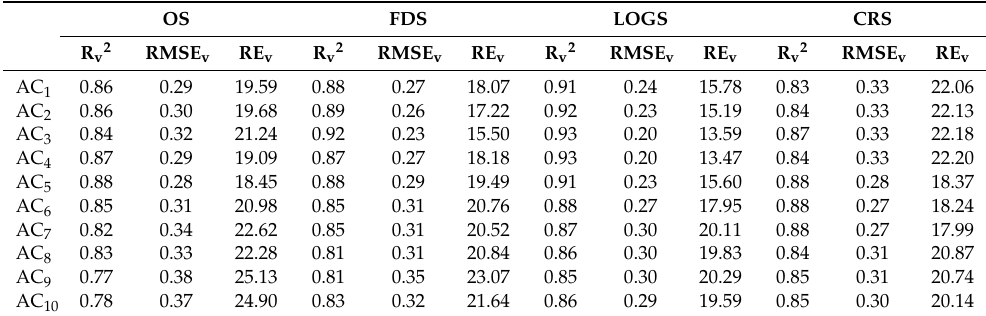
Figure 7. Relationships between determination coefficients and decomposition level of partial least squares regression models with approximation coefficients in the calibration ( a ) and validation set ( b ). Table 5. The coe ffi cient of determination, root mean square error and relative error of the validation set based on a partial least squares regression with wavelet approximation coe ffi